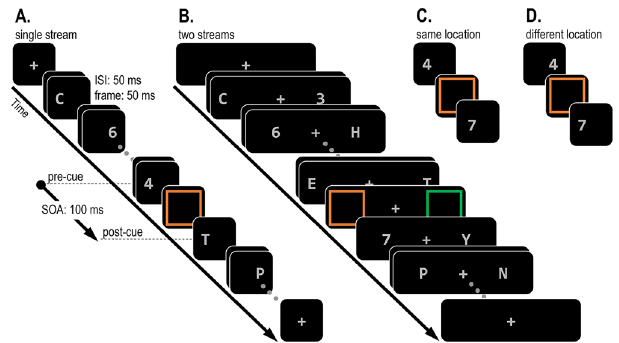
Figure 5. Illustration of the stimulus sequence in Experiment 2. Participants had to report any digit they saw inside a square in a prespecified colour (e.g., orange). The selection cue was embedded in either ( A ) a single stream or ( B ) two streams. In every stream, the item immediately before and immediately after the selection cue appeared in exactly the same location ( C ) or in a different location ( D ). In the pre-cue digit only or post-cue digit only conditions ( A – B ; 20% of trials), only one digit appeared either before or after the selection cue. In the other trials ( C – D ; 80% of trials), two different digits appeared both before and after the selection